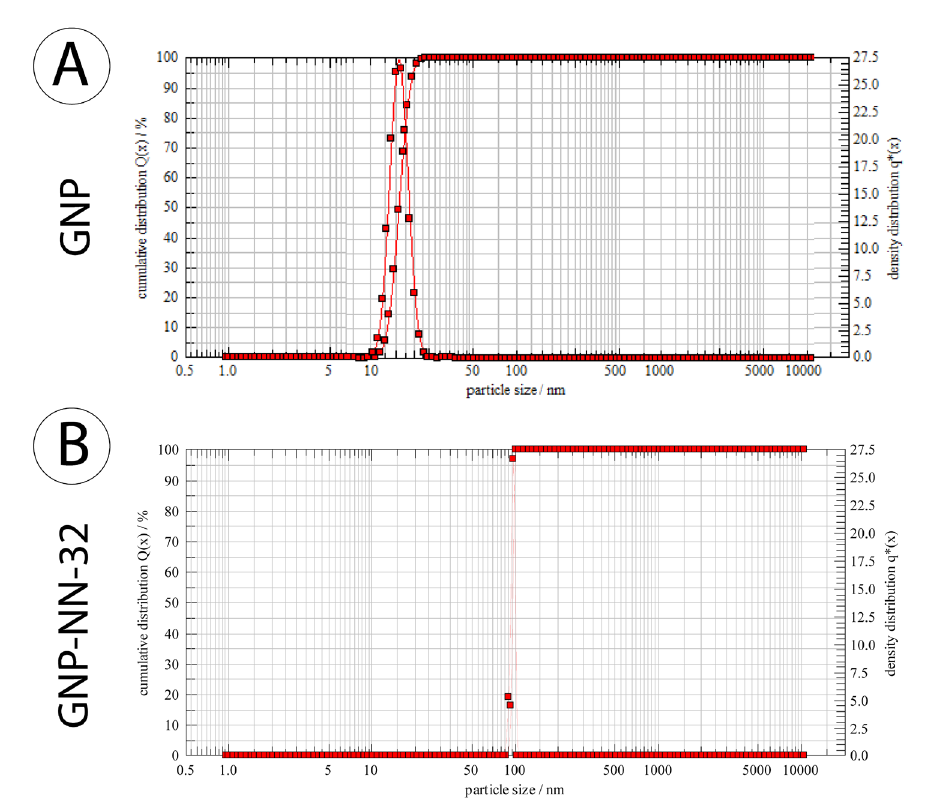
Figure 2. Characterization of GNP-NN-32 by DLS. (A) GNP, (B) GNP-NN-32.